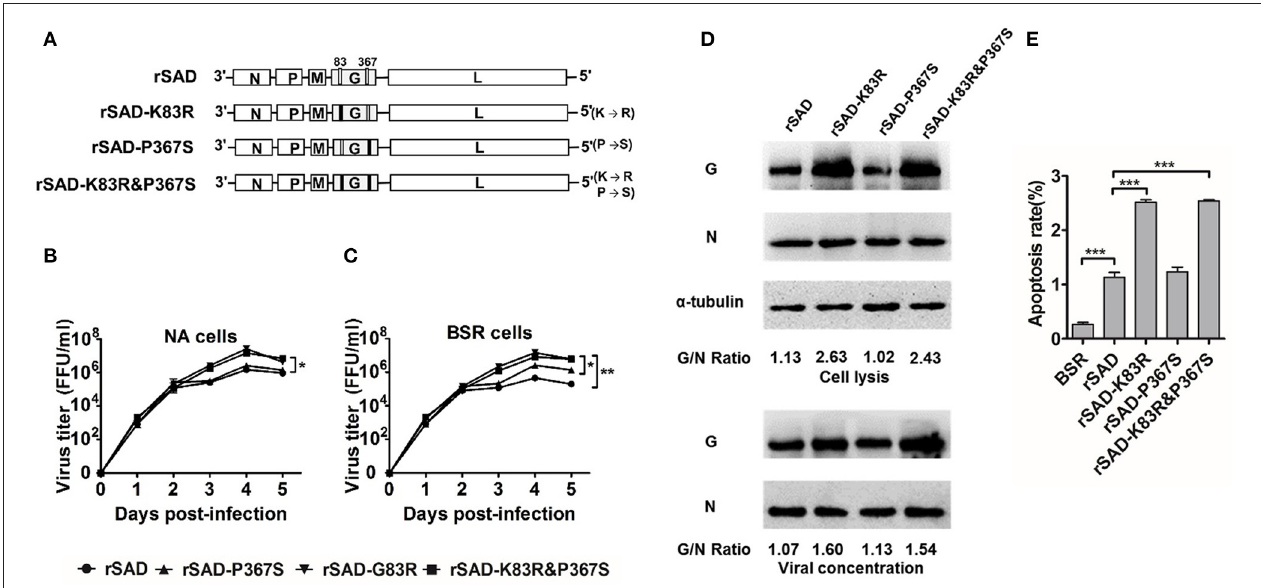
FIGURE 4 | Determination of the replicative rate of rSAD-K83R, rSAD-P367S, and rSAD-K83R&P367S. (A) Schematic diagram of the construction of rSAD-K83R, rSAD-P367S, and rSAD-K83R&P367S. (B,C) The growth curves of the recombinant RABVs determined on BSR and NA cells, respectively. Briefly, cells were infected with the indicated virus at an MOI of 0.01. The culture supernatants were collected at 1, 2, 3, 4, and 5 dpi and viral titers determined. (D) Western blot analysis of viral protein in NA cells and viral protein incorporated into the virion. The ratio between G and N was calculated from the intensity of the band using Image-Pro Plus 6.0. (E) Flow cytometry analysis of apoptosis cells infected with the indicated virus. All the titrations were carried out in quadruplicate, and each value was expressed as the mean ± SEM from three independent experiments. Significance of differences between the indicated group was assessed by the unpaired t-test. * p < 0.05; ** p < 0.01; *** p <